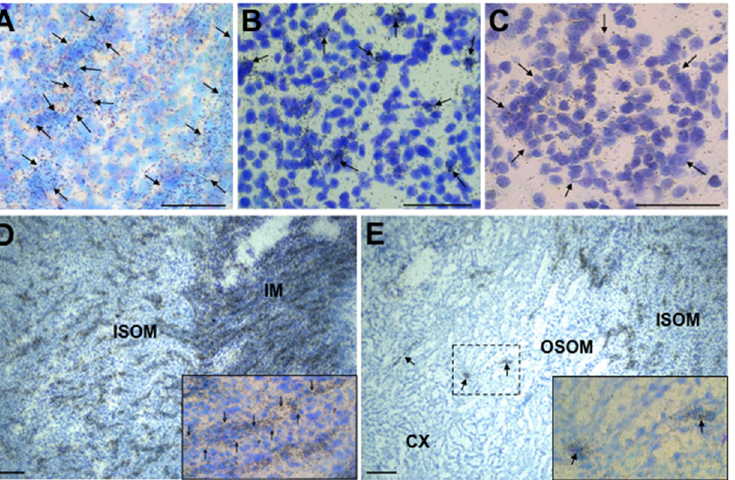
Fig 5. Brightfield images of ISHH labelling of apela and aplnr transcripts (black grains) in adult rat and mouse kidney. Apela is largely confinedto tubular structures (outlineof some arrowedin ( A )) whereas aplnr is mainly expressedin intertubular cells (arrowedin ( B )) in the rat inner medulla(IM) and outer medulla, respectively. Approx. 35% of cortical glomeruli also expressed aplnr , usuallyin a uniform distributionacross the structure (perimeter of glomerulus arrowed)—an aplnr -positiverat glomerulusis shown in ( C )). There is a clear demarcation in overall labellingin tubular structures in the transition from inner medulla(IM) to inner zone of the outer medulla(ISOM) ( D ) and from the outer medulla(tubular structures arrowed in the outer stripe of the outer medulla(OSOM)) to the cortex (CX) ( E ) in mouse kidneys. In D and E the insets are approximately 4-fold magnifications of the wide-field images, showing apela labellingin tubules (one structure arrowed) in the ISOM ( D ) and isolatedcells (from boxed area) in the OSOM ( E ). Scale bar = 50 μ min A - C , and 100 μ min D and E